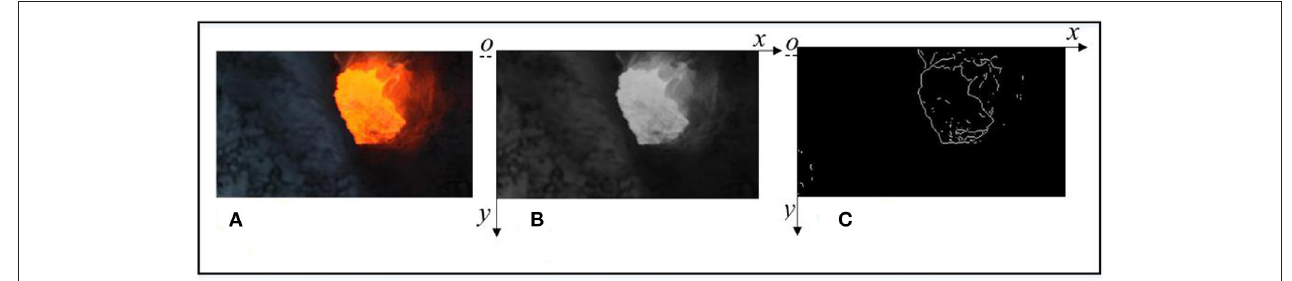
FIGURE 1 | The obtained edge feature images (Prewitt operator). (A) The original image of the fire hole. (B) The gray image of the fire hole. (C) The obtained edge feature